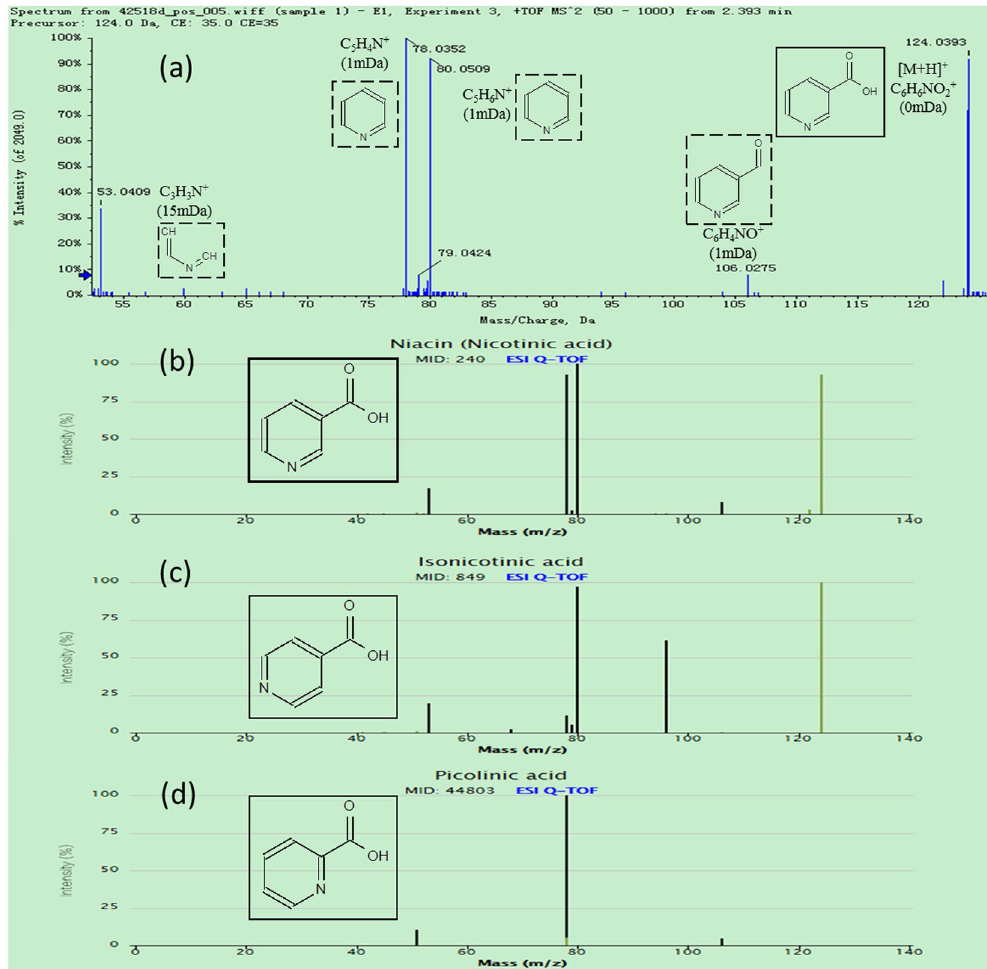
Figure 5. Data for the identification of nicotinic acid (P13): ( a ) The product ion spectrum of PB13 in positive ion mode; ( b ) MS/MS spectrum of nicotinic acid in Metlin database; ( c ) MS/MS spectrum of isonicotinic acid in Metlin database; ( d ) MS/MS spectrum of picolinic acid in Metlin